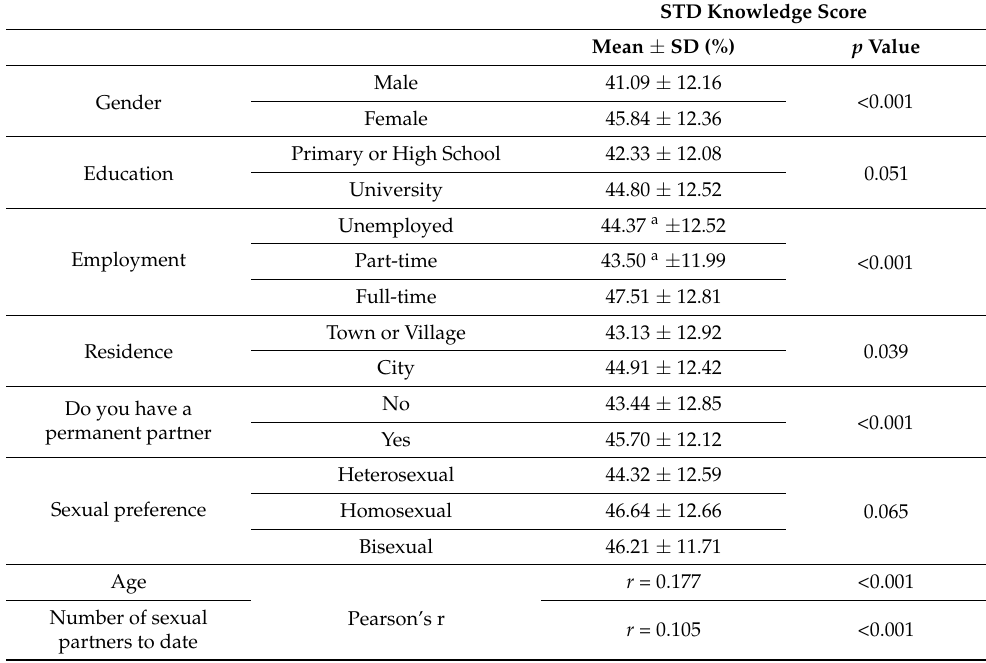
Table 5. Unifactorial analysis of STD knowledge score in relation to demographic characteristics of the young Greek population.